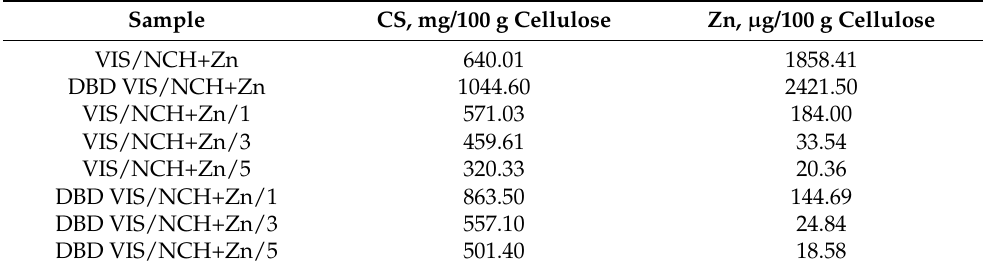
Table 3. The masses of chitosan and zinc in the NCH+Zn-functionalized viscose fabrics. Part of results previously published in